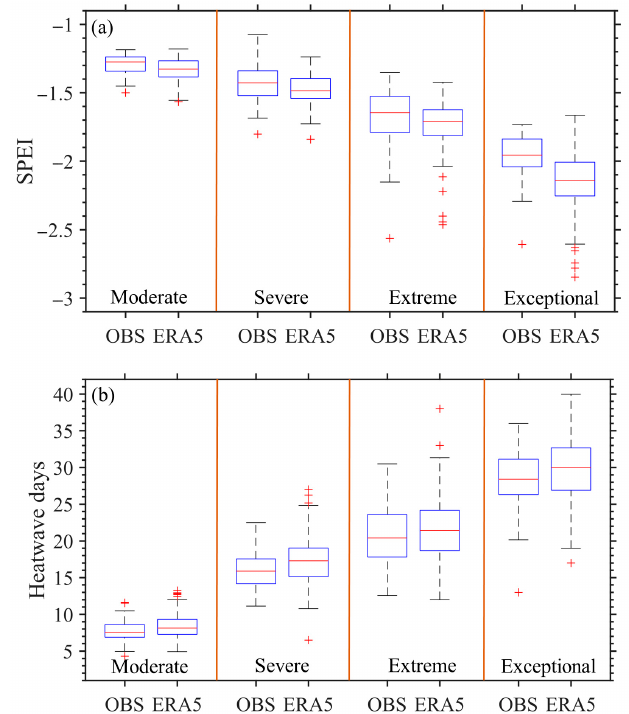
Figure 9. ( a ) SPEI values and ( b ) heatwave days under CDHW conditions at moderate, severe, extreme, and exceptional grades, relatively in the GRB during 1961–2018.